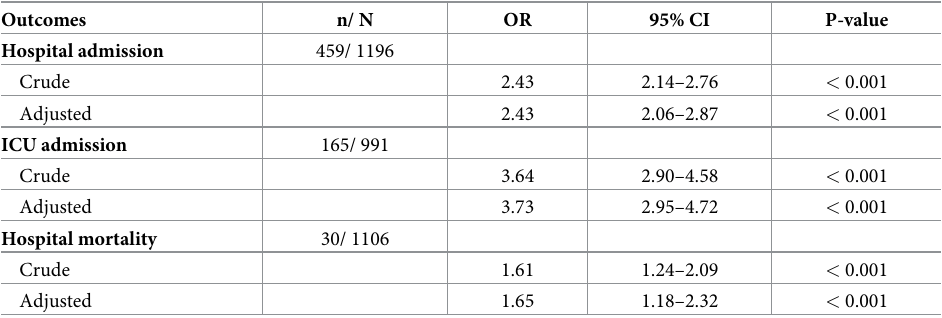
Table 3. Associations of the J-ERATO score with the outcomes in patients with heat-related